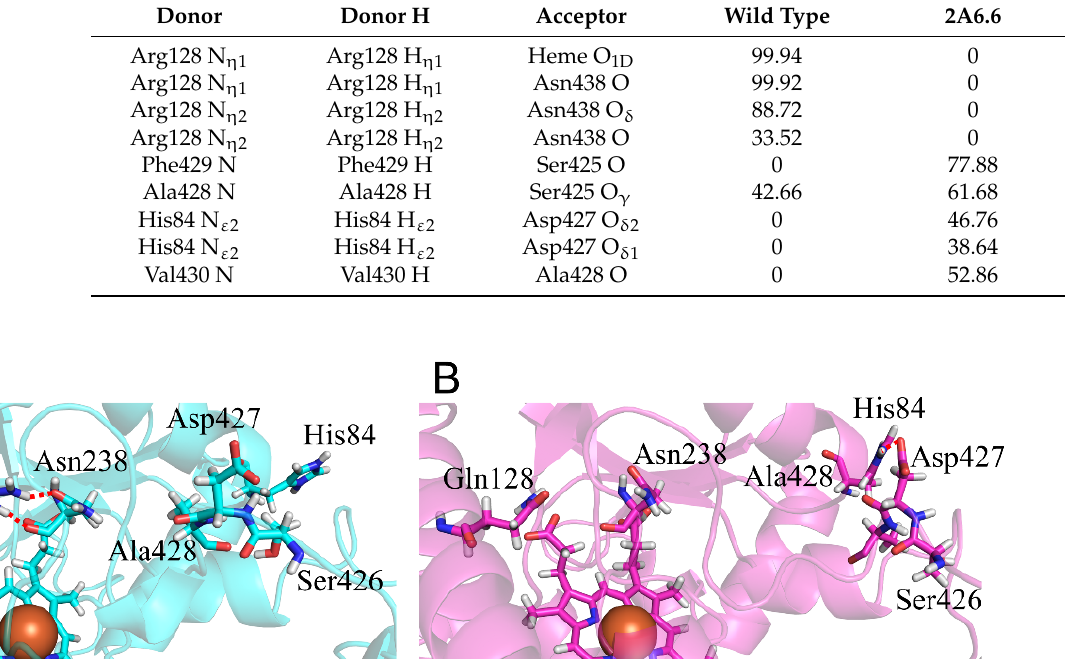
Table 4. Hydrogen bond formation involved in the structural change in CYP2A6.6.